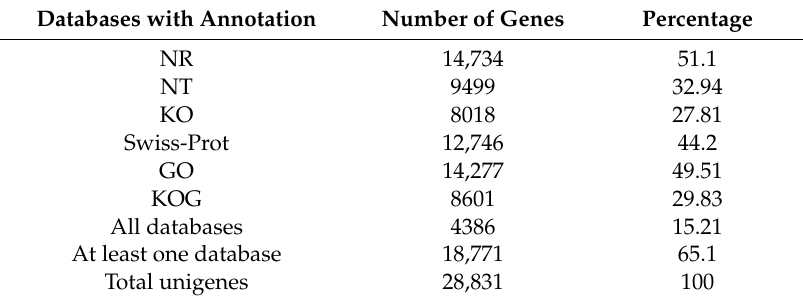
Table 2. Success rates for gene